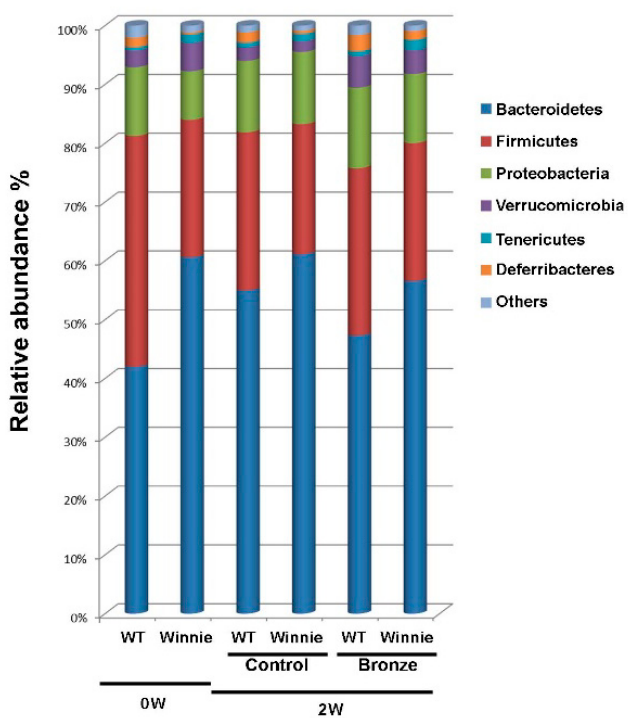
Figure 4. Total bacteria found in feces of WT and Winnie mice. Relative abundance (%) of total (16S rRNA) bacteria, found at the phylum level in the fecal samples of WT and Winnie mice at Day 0 (0W) and after two weeks (2W) on Bronze (Bronze) or Control tomato (Control) diets.